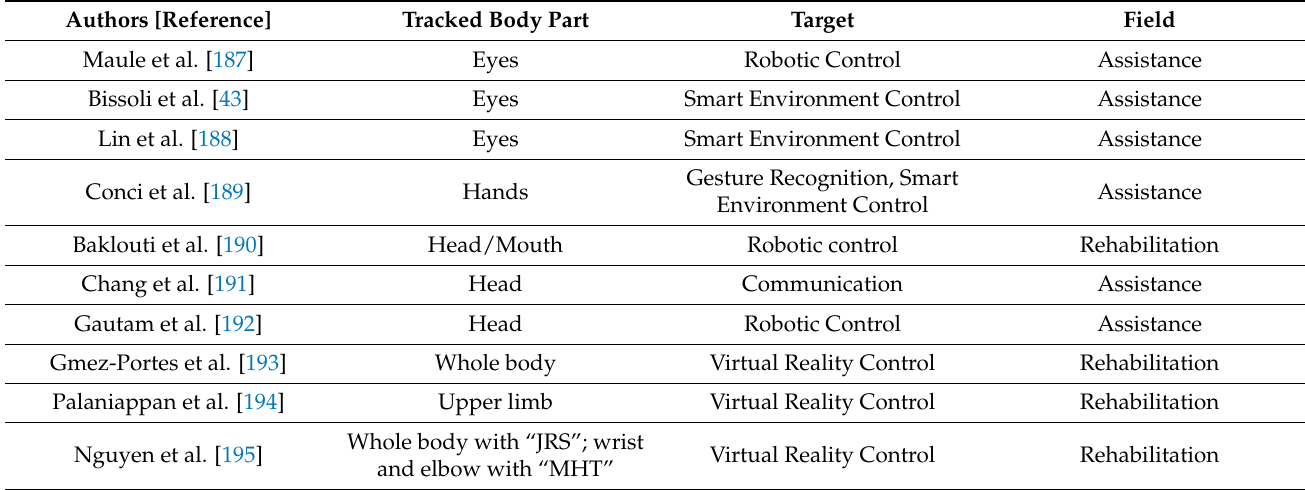
Table 11. Image-based body motion